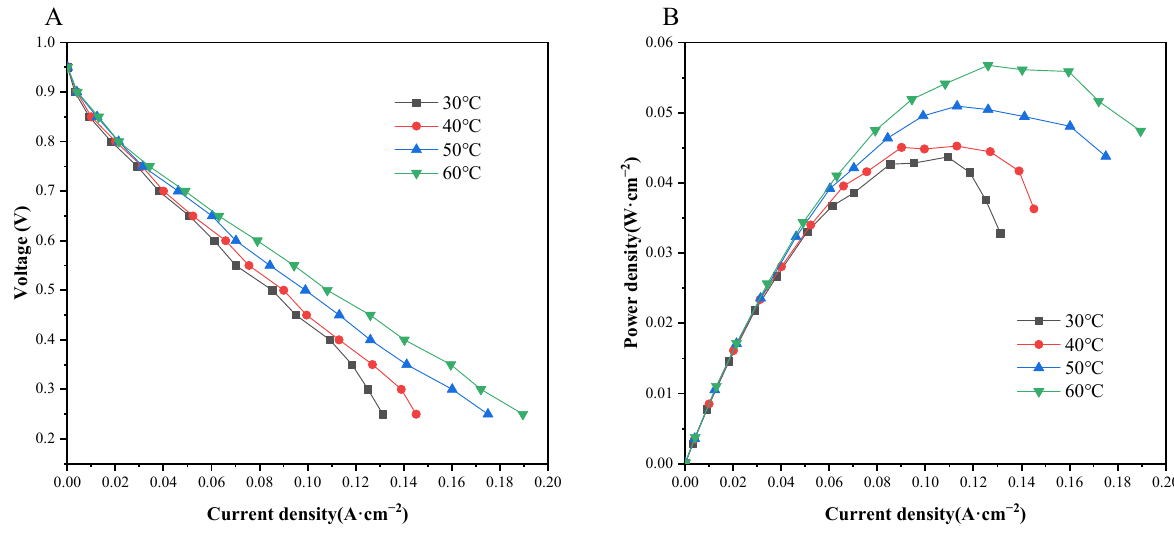
Figure 12. Fuel cell performance curves at different humidification temperatures. ( A ) Polarization curves and ( B ) power density curves.